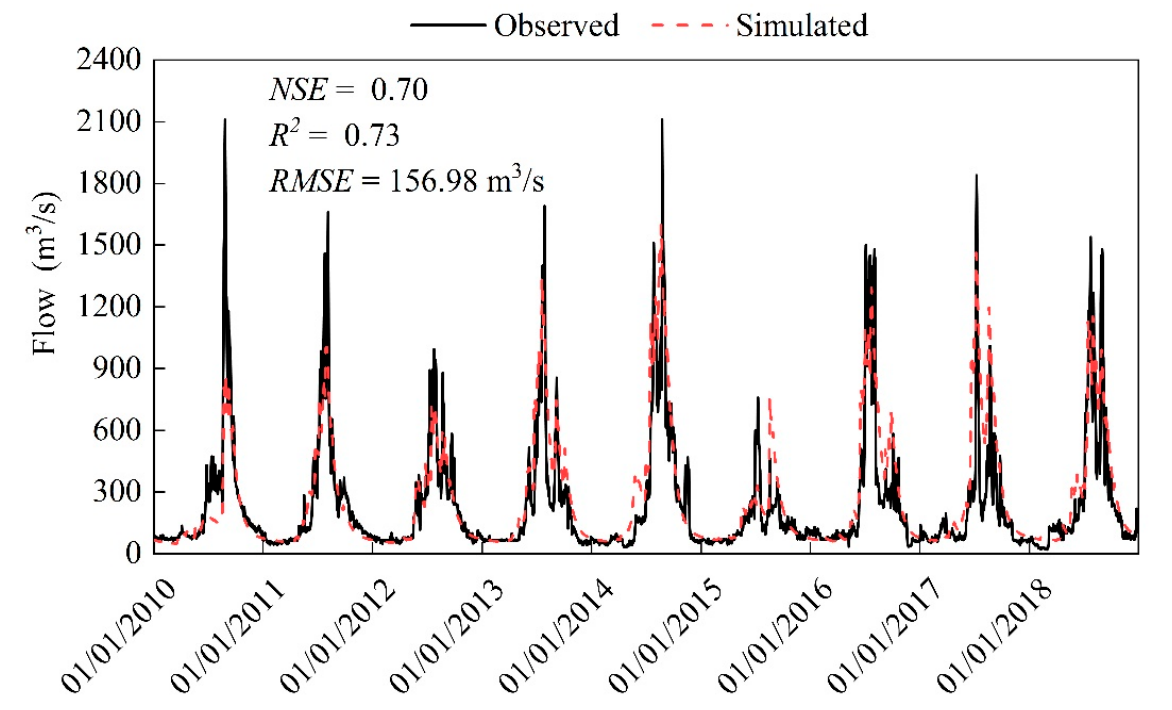
Figure 6. The time series plots between observed and simulated flow at the LHASA station from 2010 to 2018.